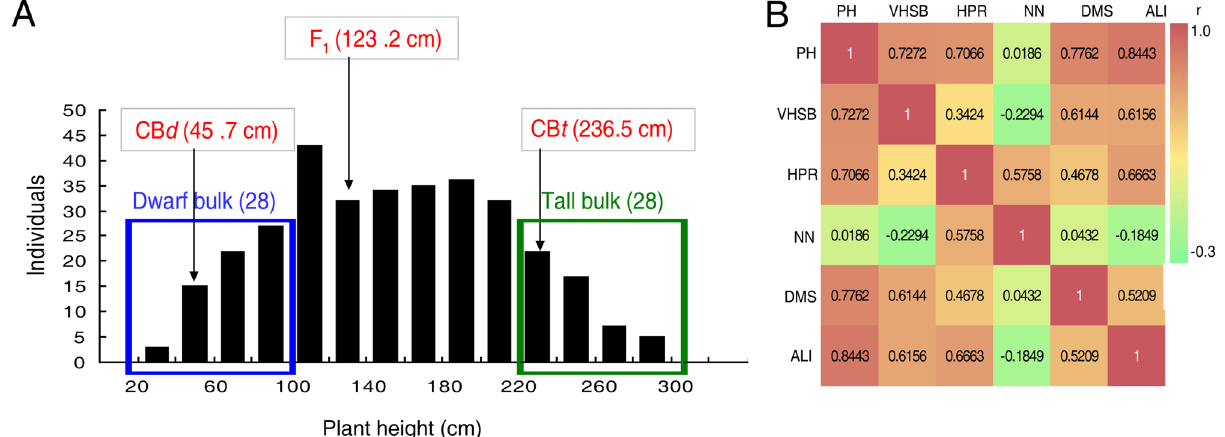
Figure 2. The segregation of plant height in the F 2 population and the correlation between six height-related phenotypes. ( A ) Frequency distribution of plant height in 330 F 2 individuals at maturity. The average values of plant height for CB t , CB d and F 1 hybrids are shown in red text. The 28 shortest individuals (< 100 cm) were selected as the dwarf bulk and the 28 tallest individuals (> 220 cm) were selected as the tall bulk. ( B ) Correlation coefficient ( r ) among six traits in the F 2 population. PH: plant height, VHSB: vertical height of the secondary branching, HPR: height of primary raceme, NN: number of nodes on main stem, DMS: diameter of main stem, ALI: average length of internodes on main